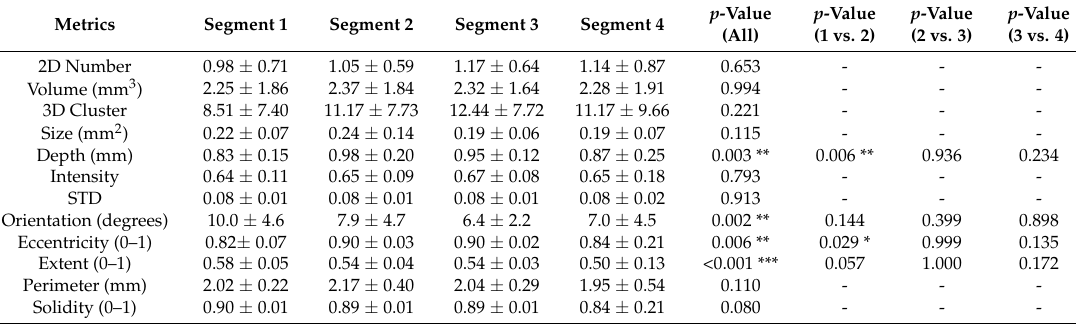
Table 2. Comparison of SHS characteristics over the 4 cm longitudinal segments in BE.